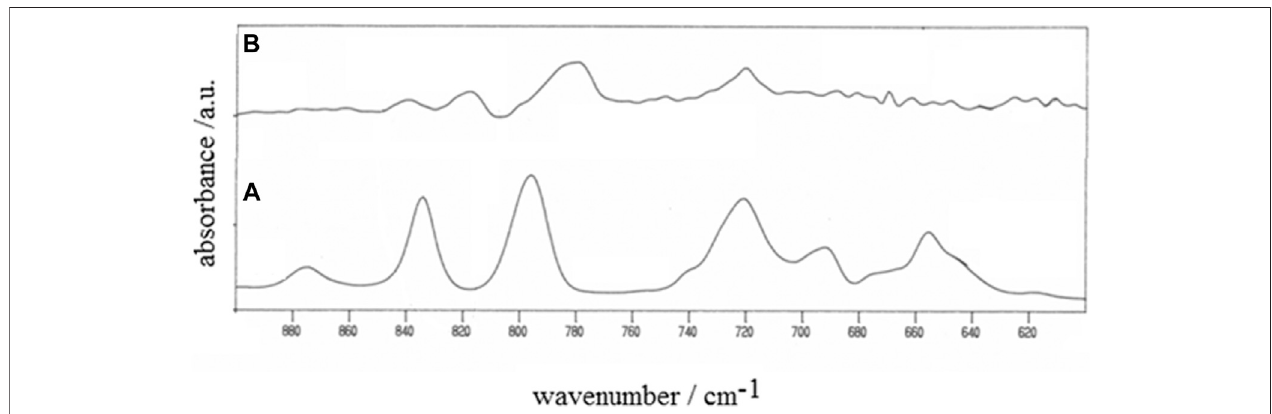
FIGURE 4 | IR spectra of (A) monomer 3,3 ″ -didodecyl-2,2 ′ :5 ′ ,2 ″ -terthiophene and (B) the corresponding electropolymerized product poly-3,3 ″ -DDTT (wavenumber range 600 – 900 cm − 1 ). The polymer was neutral as obtained at the end of the voltammetric experiment of Figure 5 ( vide infra ). The charge of polymer deposition was 25 mC. Spectra were recorded in the re fl ectance